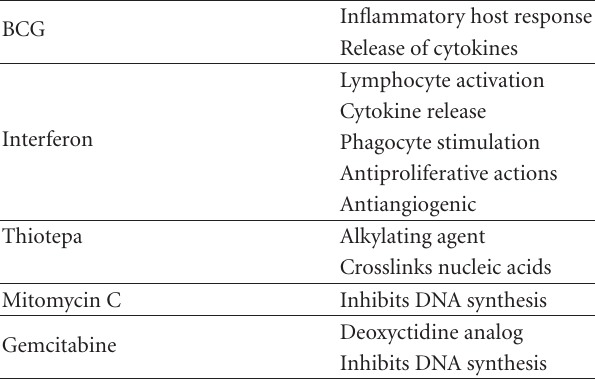
Table 1: Mechanism of immunotherapy